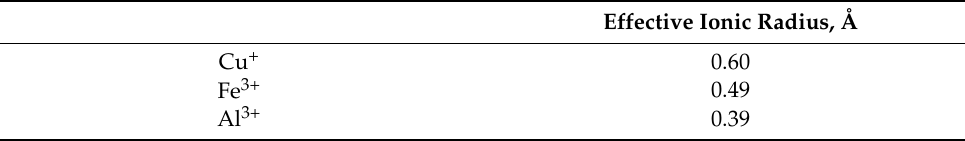
Table 1. Effective ionic radius of Cu + , Fe 3+ and Al 3+ in tetrahedral coordination [48] (the Fe 3+ ion is assumed to be in the high spin